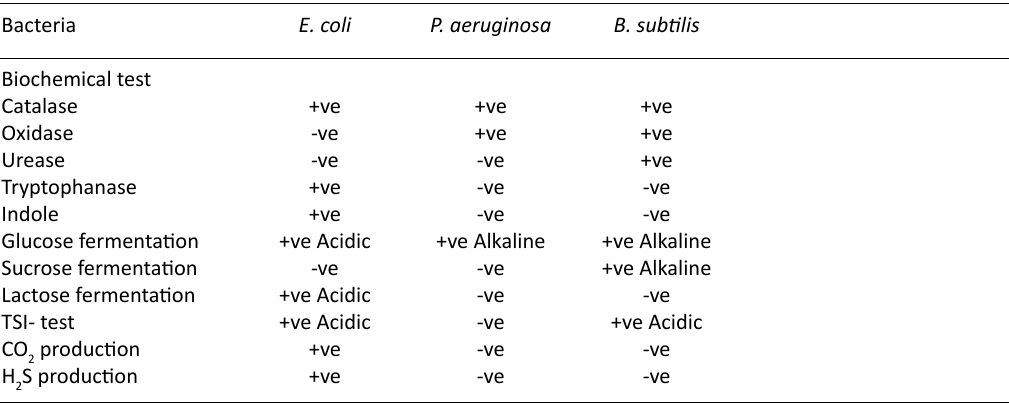
table 4. Biochemical characteristics of the isolated bacterial species Bacteria